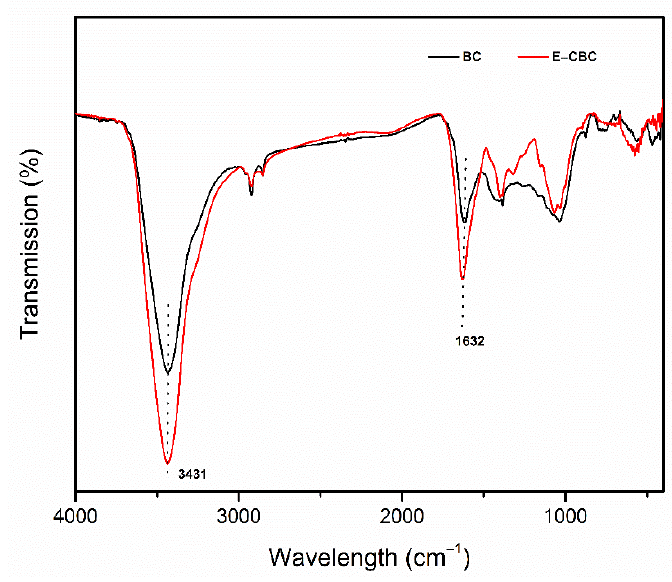
Figure 2. FTIR spectra of BC and E–CBC.